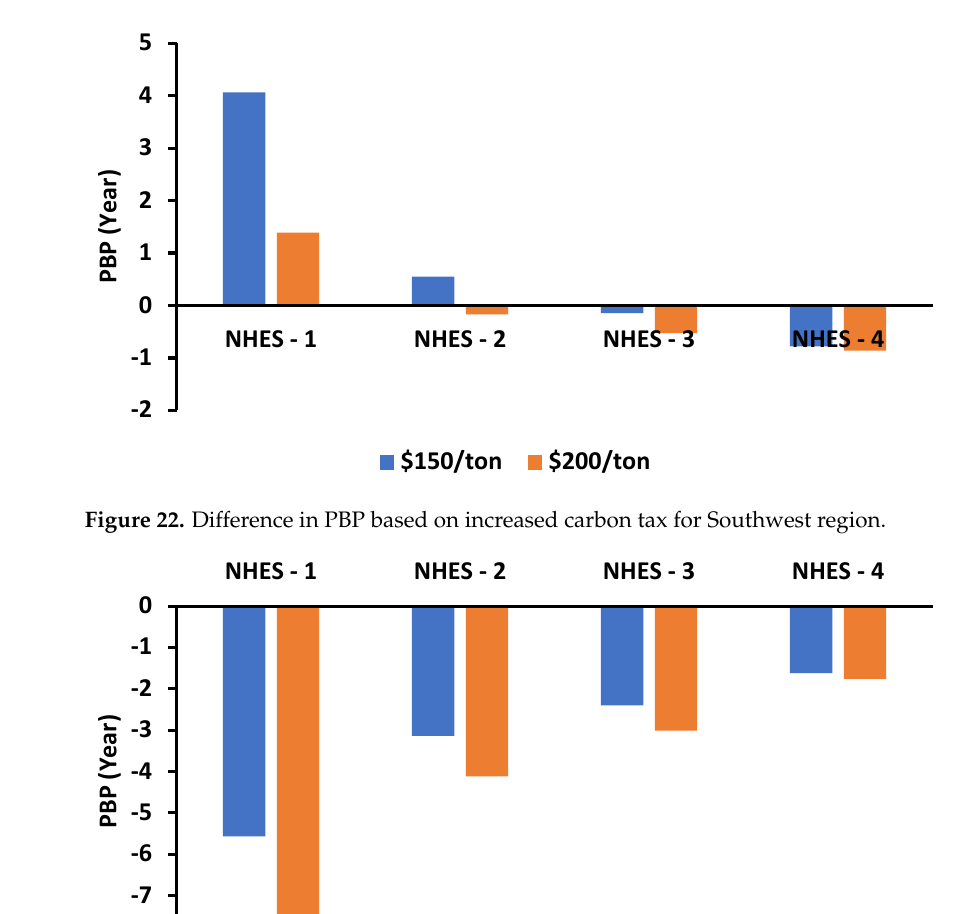
Figure 21. Difference in PBP based on increased carbon tax for Northwest region .